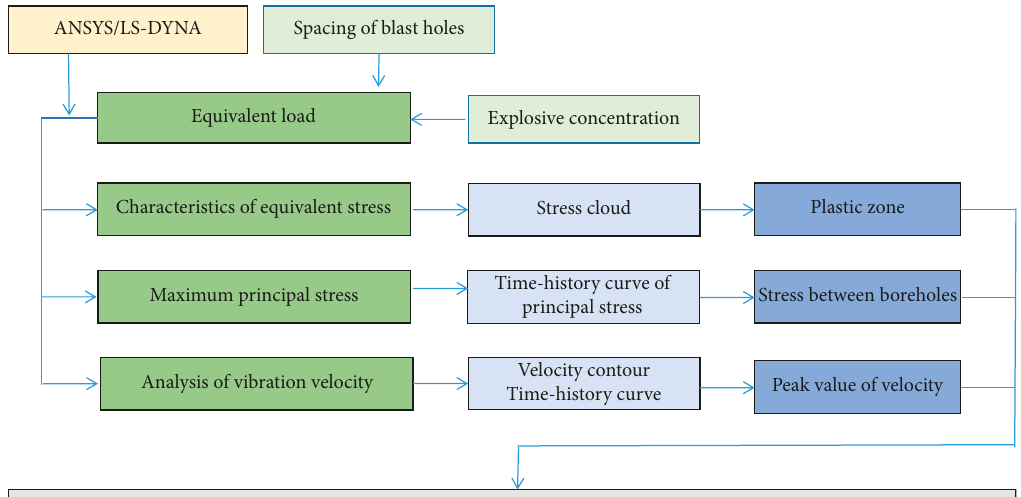
Figure 23: The influence of blasthole spacing and explosive concentration on the blasting effect